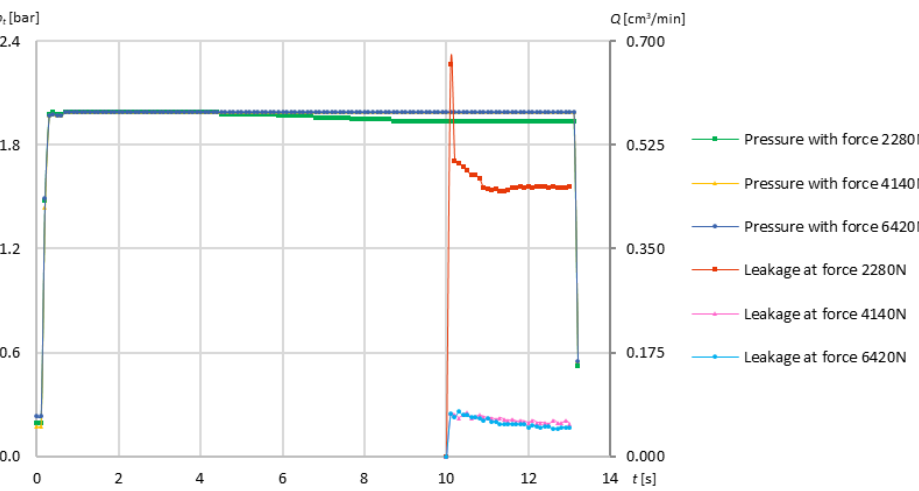
Figure 8. Graph of dependence for a pair of samples 1–2, produced with comparable surface topography parameters for different test cases, i.e., different compressive forces.